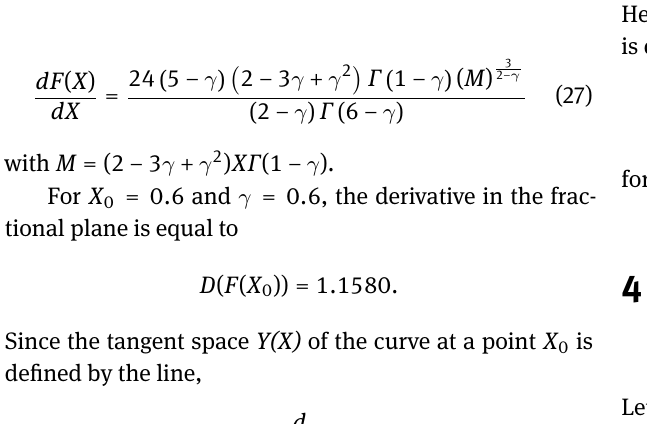
Figure 2: The curve in the Fractional Space (X,F(X)) for 𝛾 = 0.6